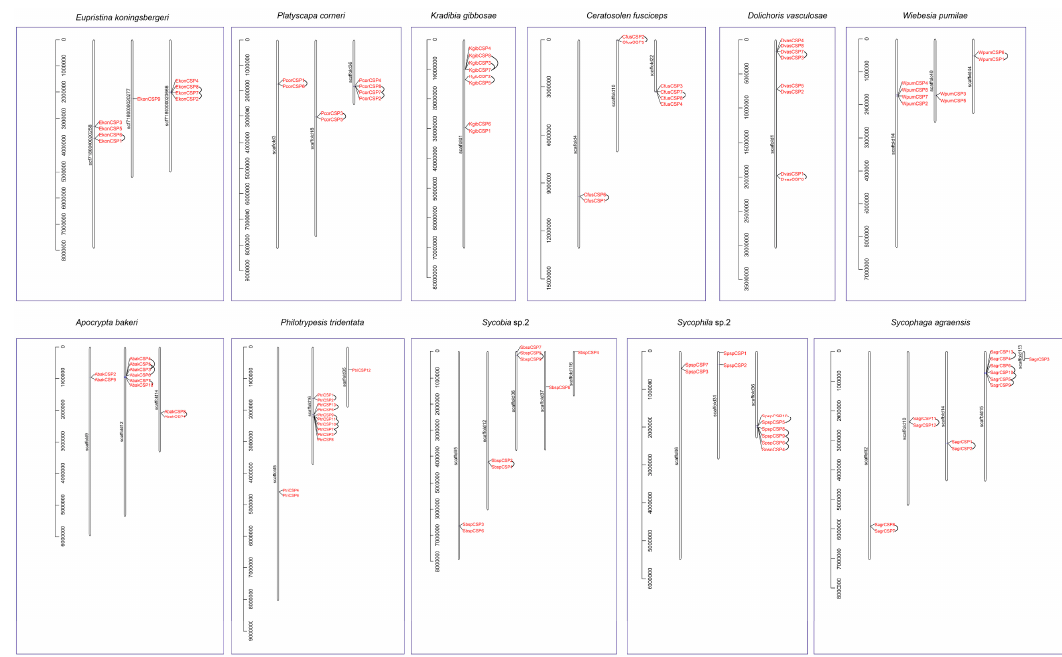
Figure 4. Scaffold location and gene tandem duplication of all CSP genes. The tandem duplicated genes are marked by black lines.